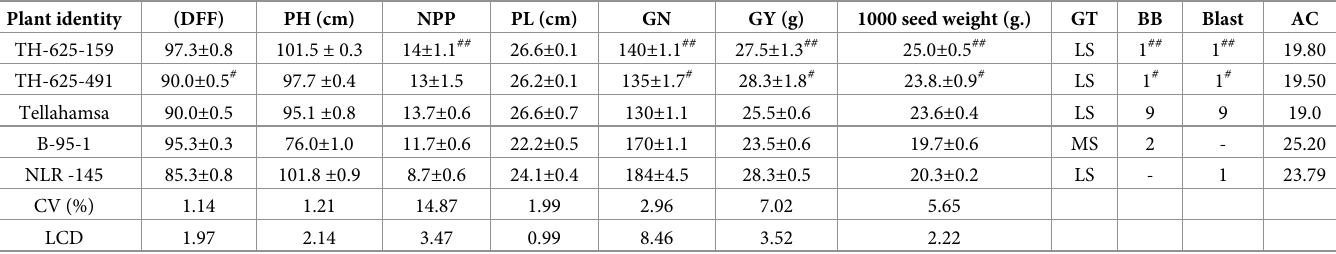
Table 2. Agro-morphological characters, disease resistance and amylose content of selected ICF 3 lines. Plant